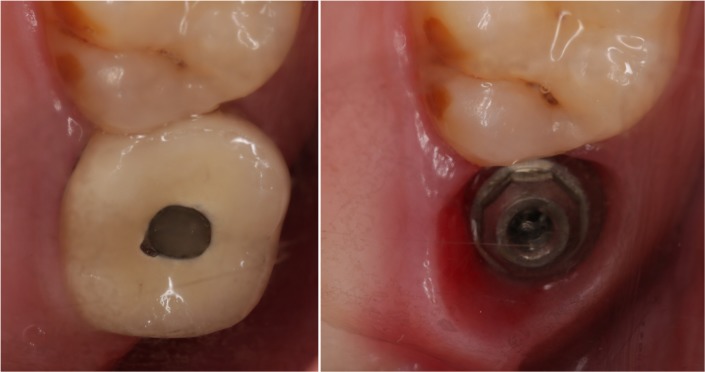
Occlusal view of a crown with a loose abutment screw and swollen mucosa around implant platform.